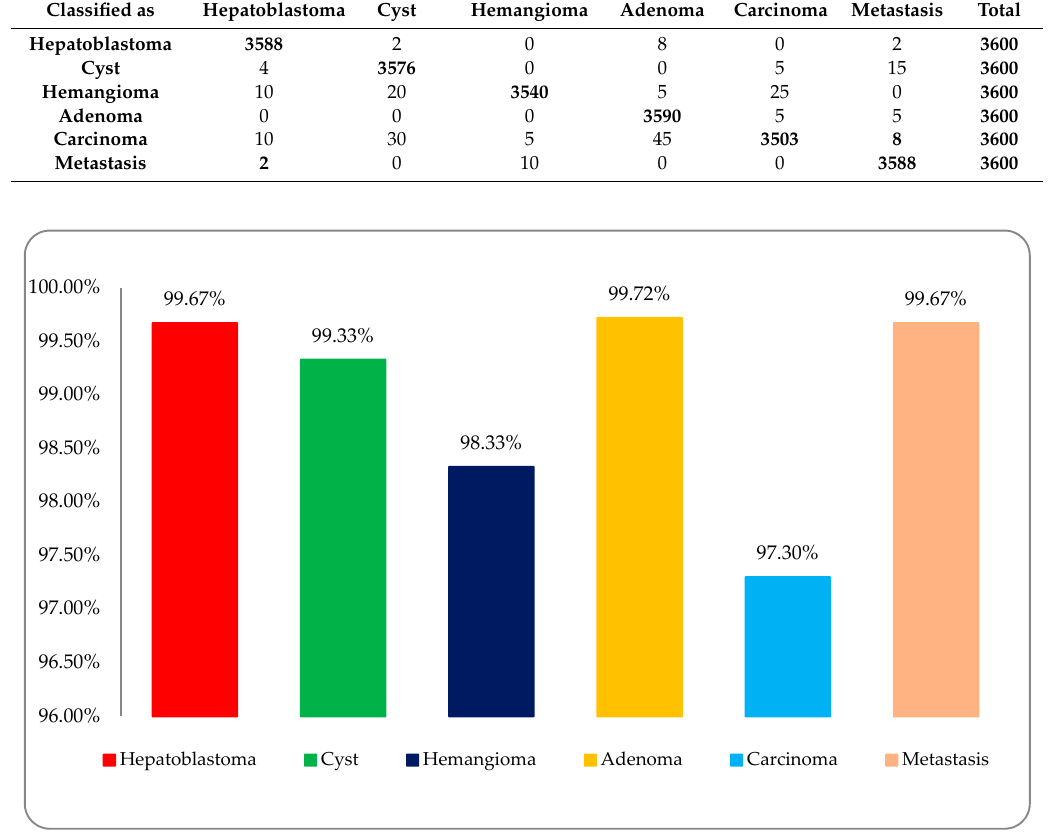
Figure 9. Classification accuracy graph of the six liver cancer types using the MLP classifier on the